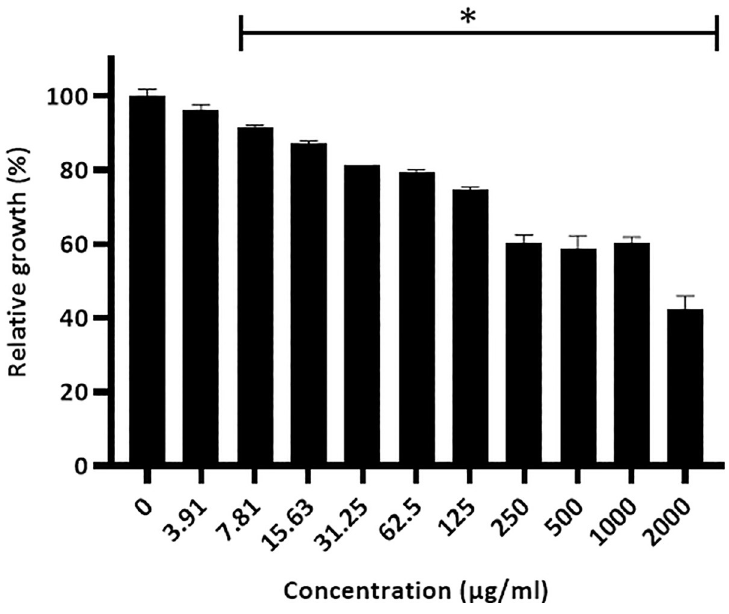
Fig 1. Effect of the tart cherry extract on the growth of P . gingivalis . A 100% value was attributed to the control (no tart cherry extract). Results are expressed as the means ± SD of triplicate assays from two independent experiments. � , Significantly different ( p < 0.01) from the control (no tart cherry